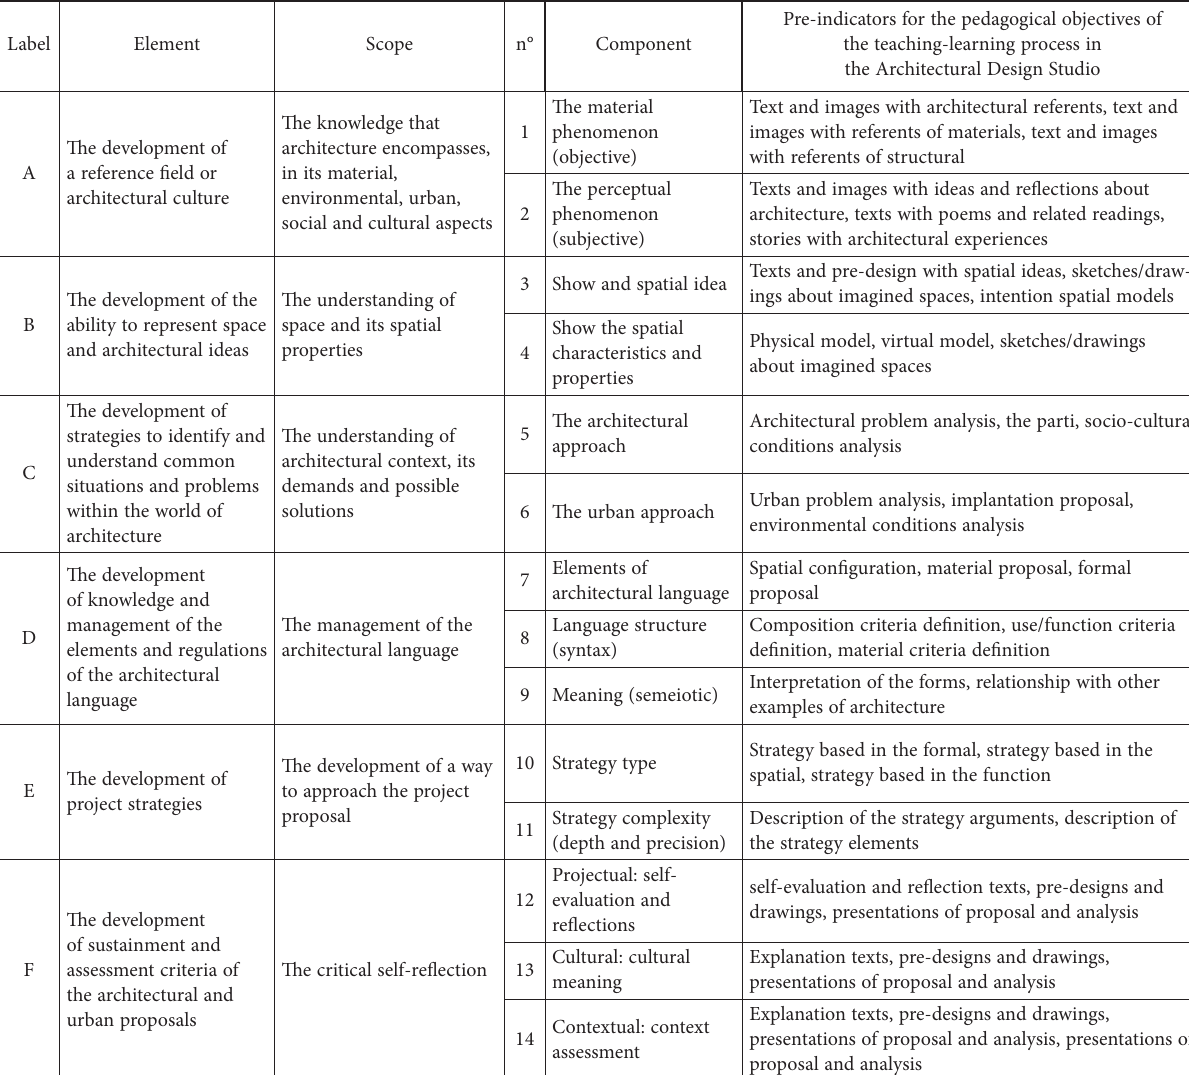
Table 1. Framework of theoretical relationship of the elements of architectural learning and the possible types of evidences (source: Authors, 2019)